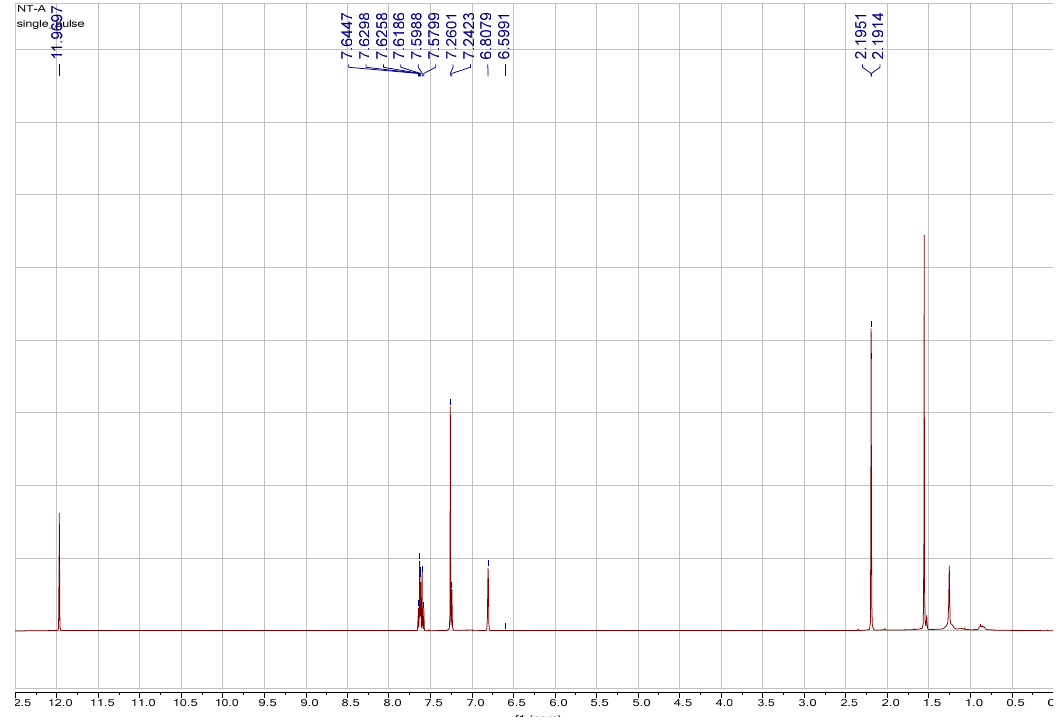
Figure 1. Spectrum data of 1 H of the major compound isolated from EANT. Fig. 1. Spectrum data of 1 H of the major compound isolated from EANT. Fig. 1. Spectrum data of 1 H of the major compound isolated from EANT.